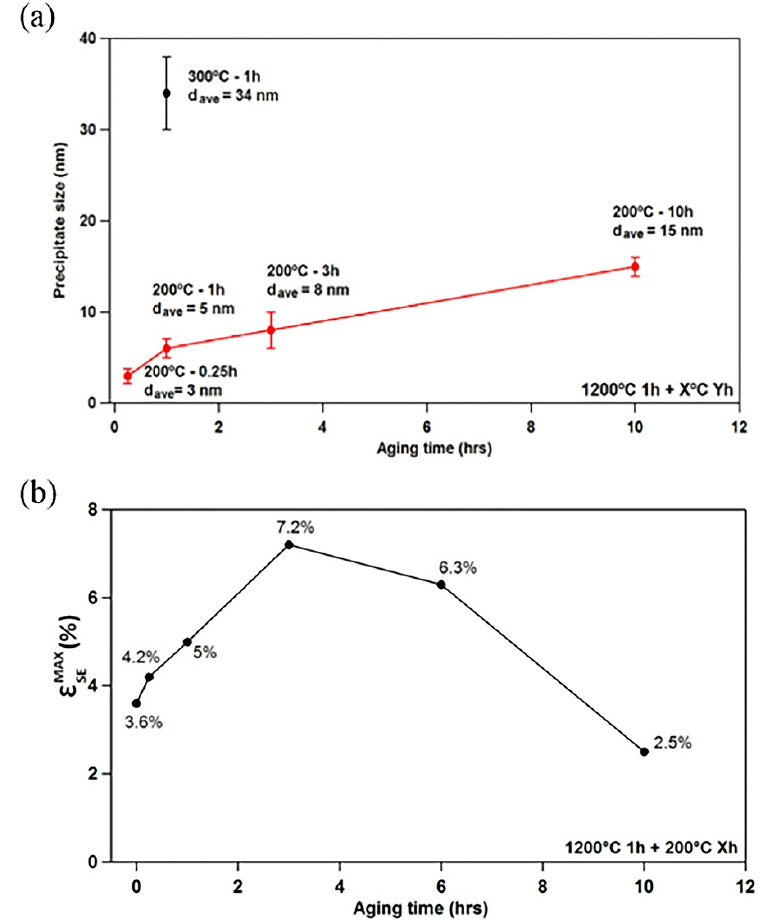
Figure 6. ( a ) The relationship between aging time and the size of B2 phase; ( b ) the relationship between aging time and superelasticity in FeMnAlNi single crystal [81]. Reprinted with permission from Ref. [81]. Copyright 2015 Elsevier.